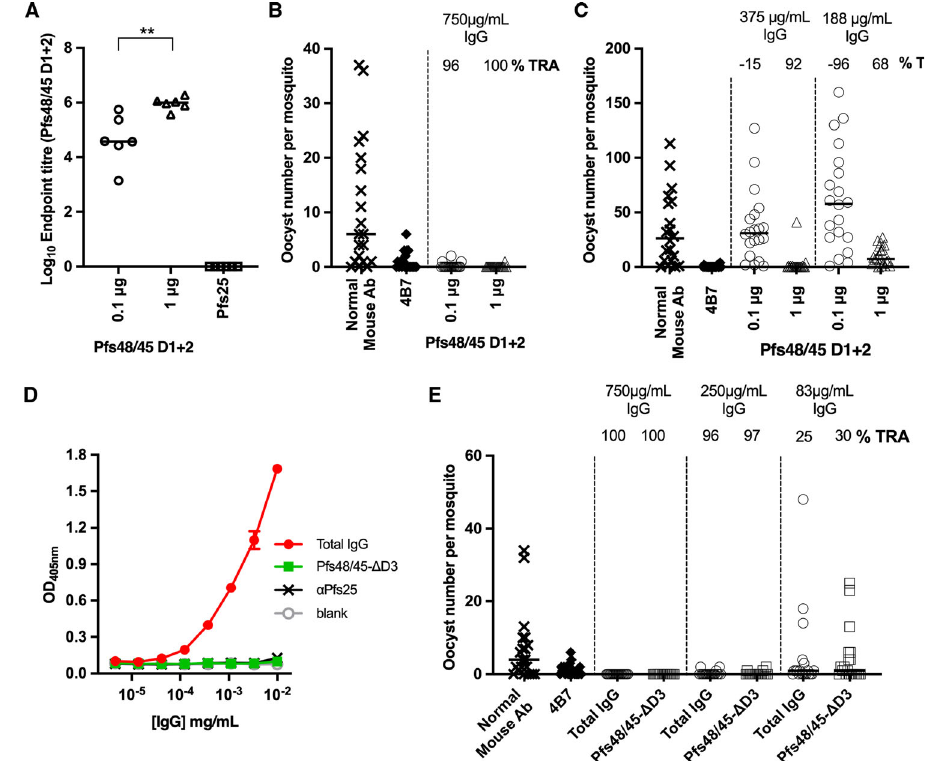
Fig. 5 | Transmission-blocking antibodies target the N-terminal and central domains of Pfs48/45. A – C Female CD1 mice ( n =6 mice) were immunised twice with either 0.1 μ g or 1 μ g of Pfs48/45-D1+2, or 1 μ g of Pfs25. Sera was collected three weeks after the fi nal dose for analysis. A IgG titres as measured by endpoint ELISA using Pfs48/45-D1+2 as the coating antigen. Each symbol is for the serum sample from an individual mouse; lines represent the median of each group. Mann – Whitney two-tailed test was performed to compare the two Pfs48/45-D1+2 groups ( p =0.0043). B , C Transmission-blocking ef fi cacy of IgG induced by immunisation with Pfs48/45-D1+2. Total IgG was puri fi ed from the pooled serum of each group (3 weeks post-boost) and mixed with P. falciparum NF54 cultured gametocytes at 750 μ g/mL ( B ) and in a separate experiment at 375 μ g/mL and 83 μ g/mL( C )andfedto A.stephensi mosquitoes( n =20mosquitoespertestgroup of pooled IgG in a single feed experiment). IgG from naive mice was used as a negative control ( “ normal mouse Ab ” ); the transmission-blocking anti-Pfs25 mAb 4B7 was used as a positive control at a concentration of 94 μ g/mL. Data points